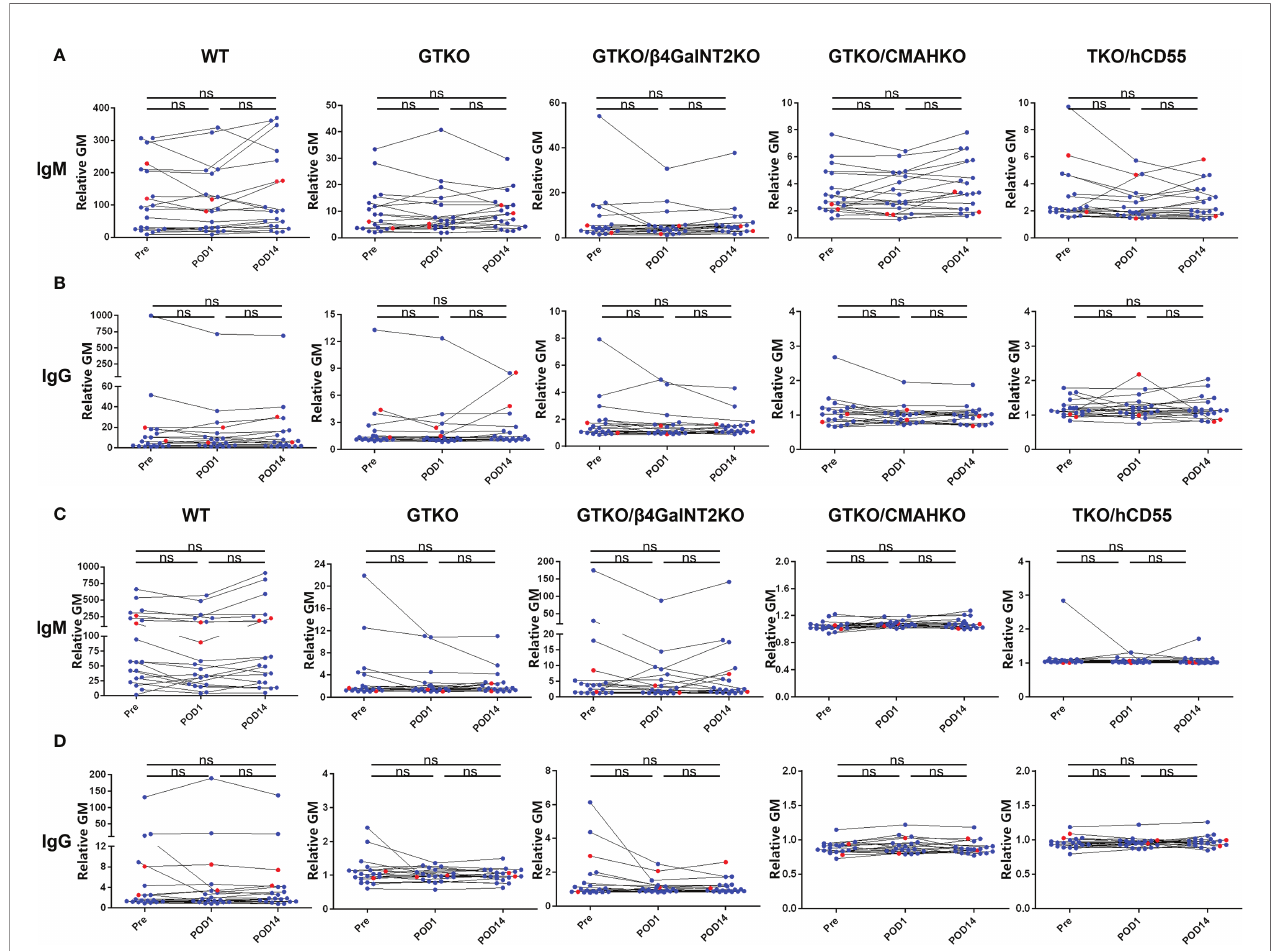
FIGURE 5 | Changes in IgM and IgG binding to pig cells in patients with ESRD pre and early post-renal allotransplantation. Serum samples from renal allotransplant recipients were collected Pre, and on POD1 and POD14 to measure IgM (A) and IgG (B) binding to pig PBMCs or to pig RBCs (C, D) . In the majority of cases, there were no signi fi cant changes in binding between the time-intervals, although in some there was a transient reduction in IgM and IgG binding on POD1 (possibly associated with hemodilution or binding to the pig cells) that had recovered to Pre levels by POD14. In two sera, IgG binding to GTKO PBMCs increased on POD14 compared with Pre and POD1, but there was no change in binding to GTKO RBCs, nor to pig cells of other genotypes. (ns, not signi fi